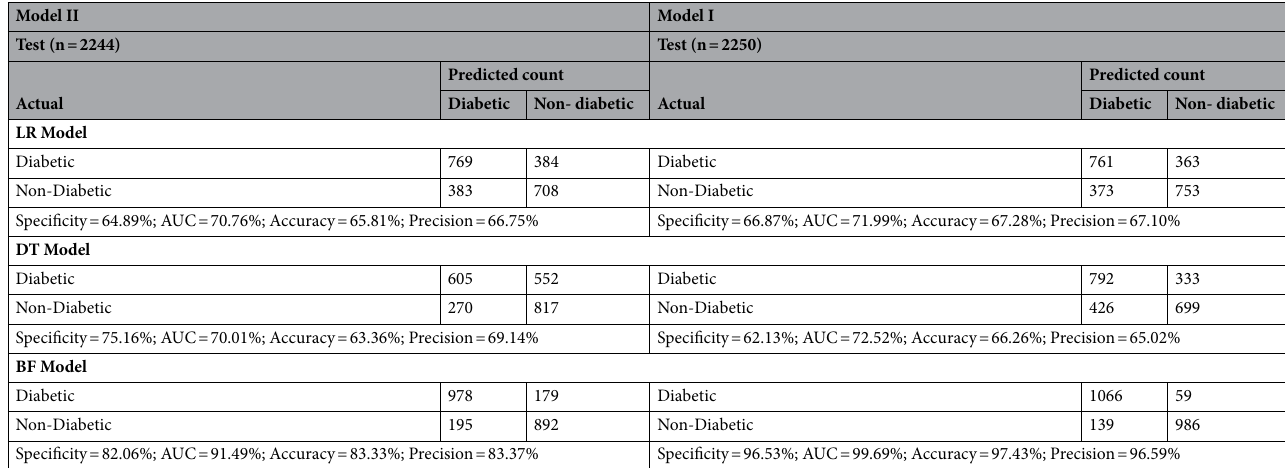
Table 4. Model performance indices of the LR, DT, and BF algorithms for models I and II.